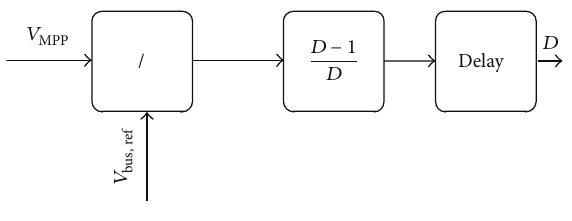
Figure 8: Duty cycle calculator.